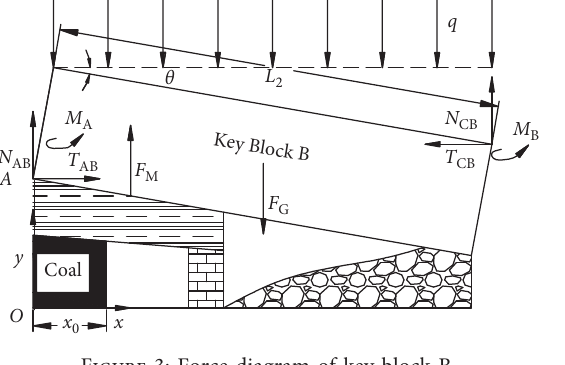
Figure 3: Force diagram of key block